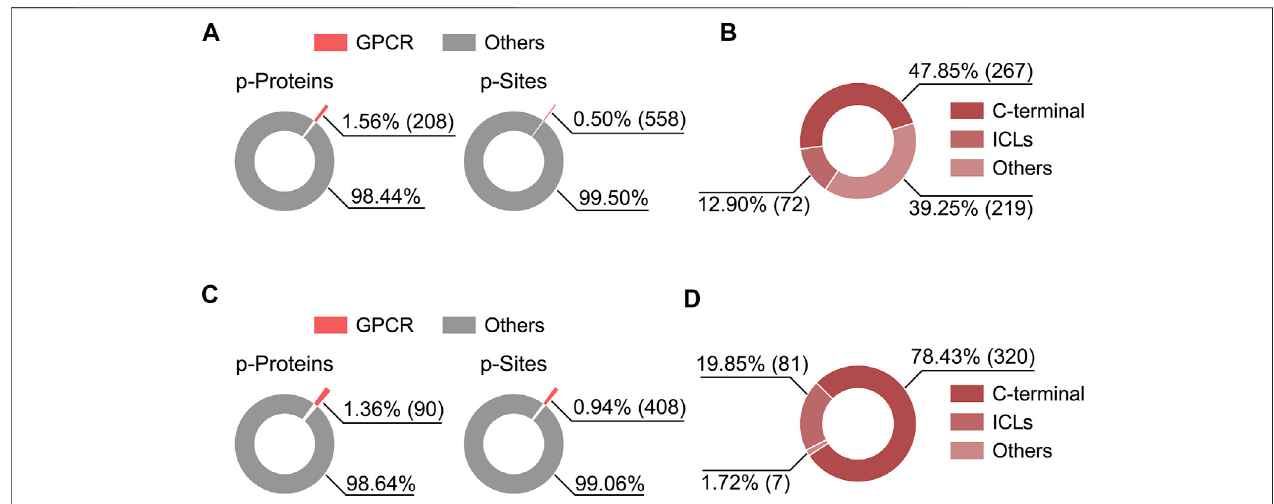
FIGURE 2 | Percentage of phosphorylated GPCRs and their phosphosites in the total identi fi cations from two published phophosproteomics datasets (A,C) , and the distribution of identi fi ed phosphosites on GPCR topological domains (B,D) . (A,B) Results based on a human phosphoproteome dataset (Lawrence et al., 2016). (C,D) Results based on a mouse brain phosphoproteomics dataset (Liu et al., 2018). Criteria for phosphoprotein and phosphosite identi fi cation are PSM FDR < 0.01, phosphopeptide FDR < 0.05, and Ascore > 13 at the phosphosite level for (A,B) , and PSM FDR < 0.01, protein FDR < 0.01, and phosphosite localization probability > 0.75 for (C,D)